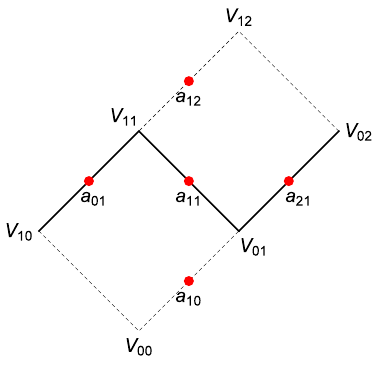
Figure 2 . Two adjacent patches on the worldsheet. V 00 and V 12 can be computed using the interpolation ansatz. Then, the five left-handed Toda variables a ij computed from the difference vectors will satisfy the Toda-type equation of